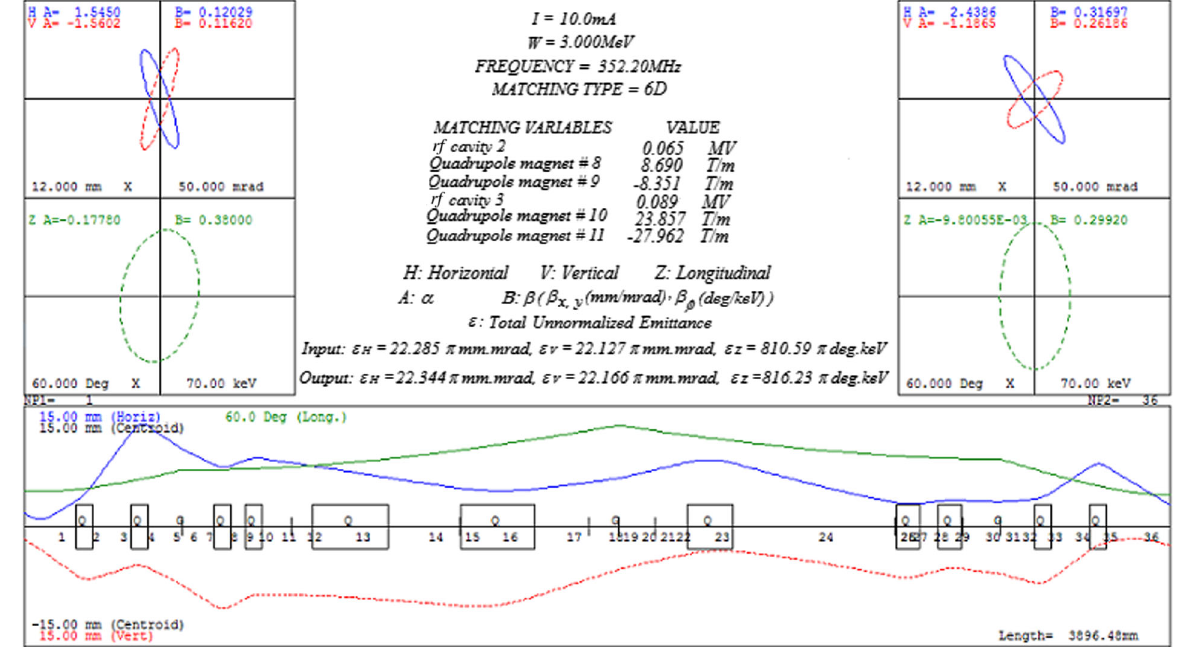
FIG. 11. TRACE 3-D output for matching the 10 mA RFQ output beam to the DTL by six transverse and longitudinal MEBT knobs. The knob numbers are indicated in Fig.